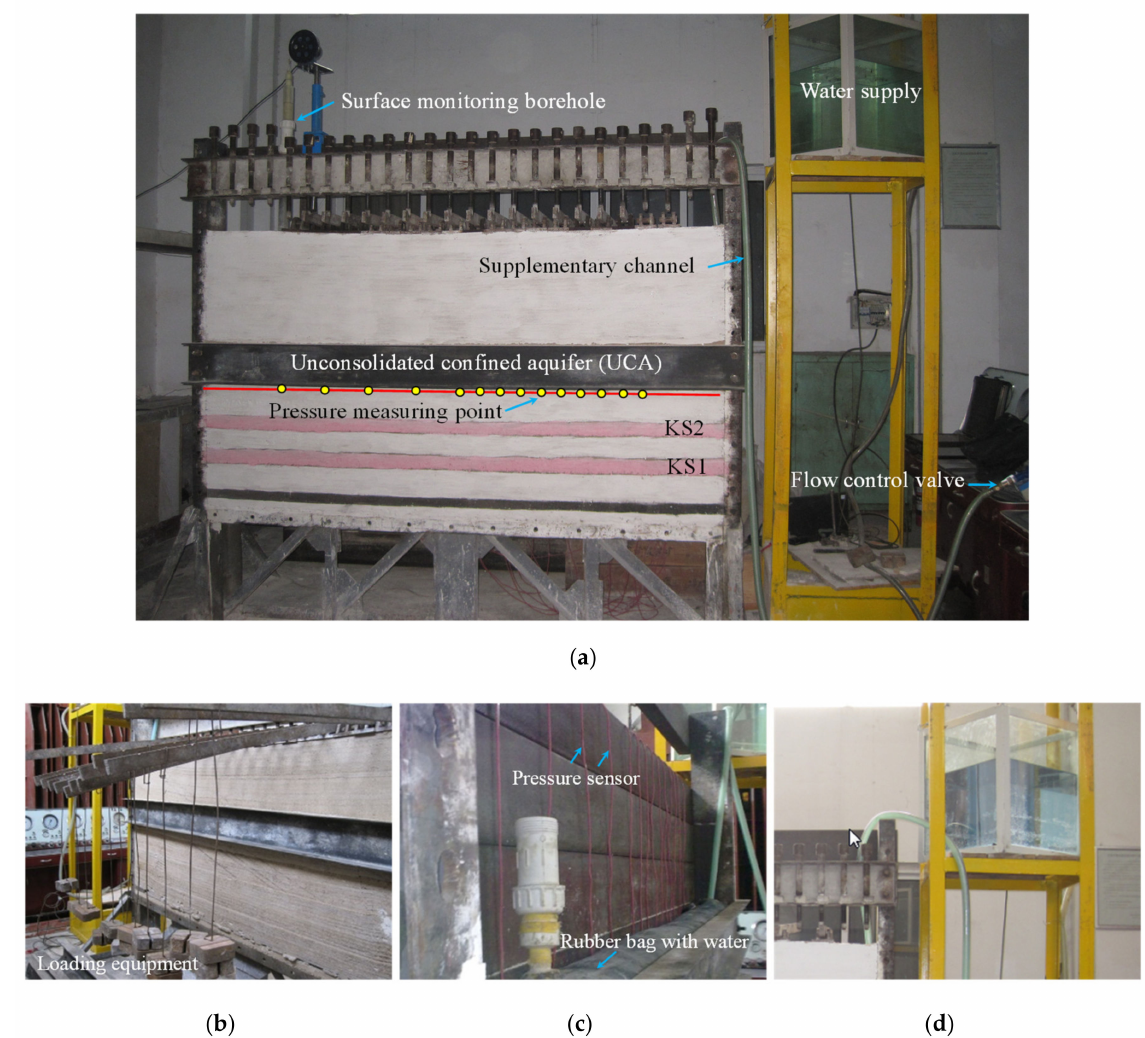
Figure 4. Simulation experiment system: ( a ) simulation experiment system; ( b ) loading equipment; ( c ) pressure sensor and rubber bag with water; ( d ) water